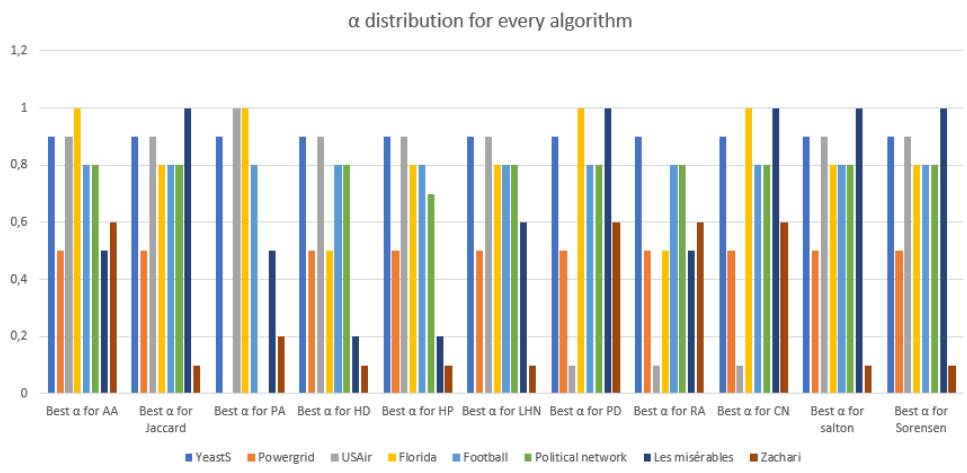
Figure 3. The α distribution on each